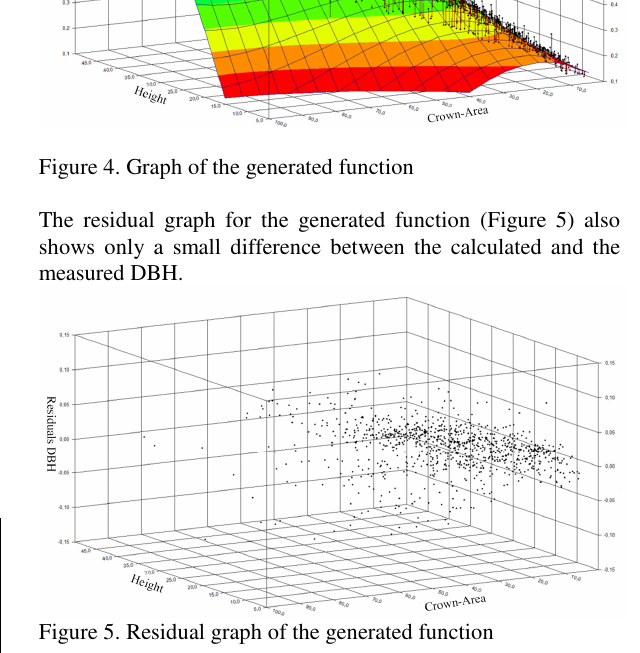
Figure 5. Residual graph of the generated